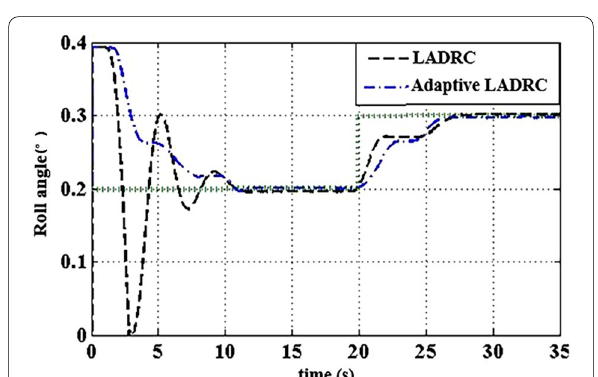
Figure 9 Comparison for small